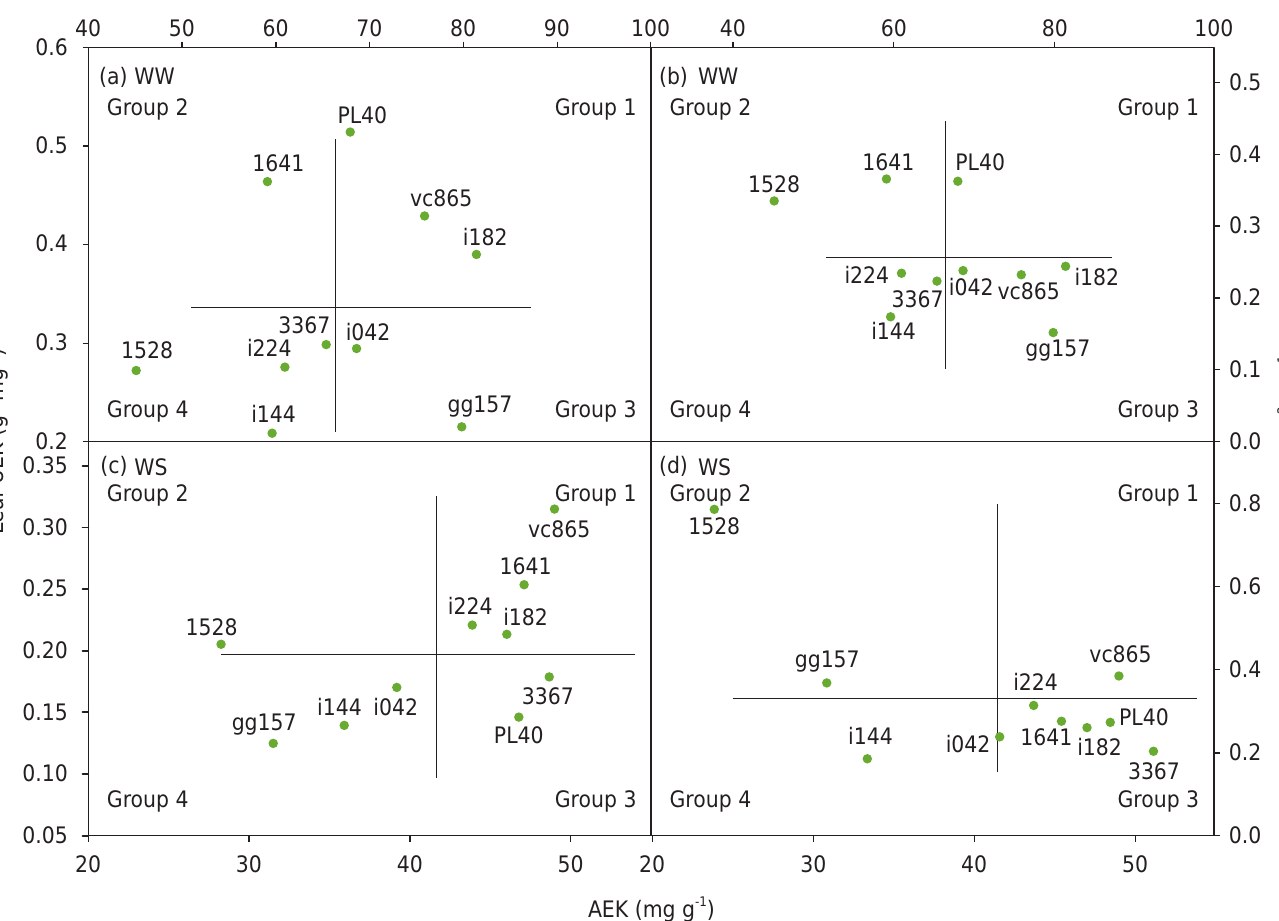
Figure 2. Distribution diagram of K absorption efficiency (AEK) and K use efficiency in leaves (leaf UEK) (a) and roots (root UEK) (b) of well-watered (WW) plants; and of the absorption efficiency (AEK) and K use efficiency in leaves (leaf UEK) (c) and roots (root UEK) (d) of water-stressed (WS) seedlings of ten Eucalyptus